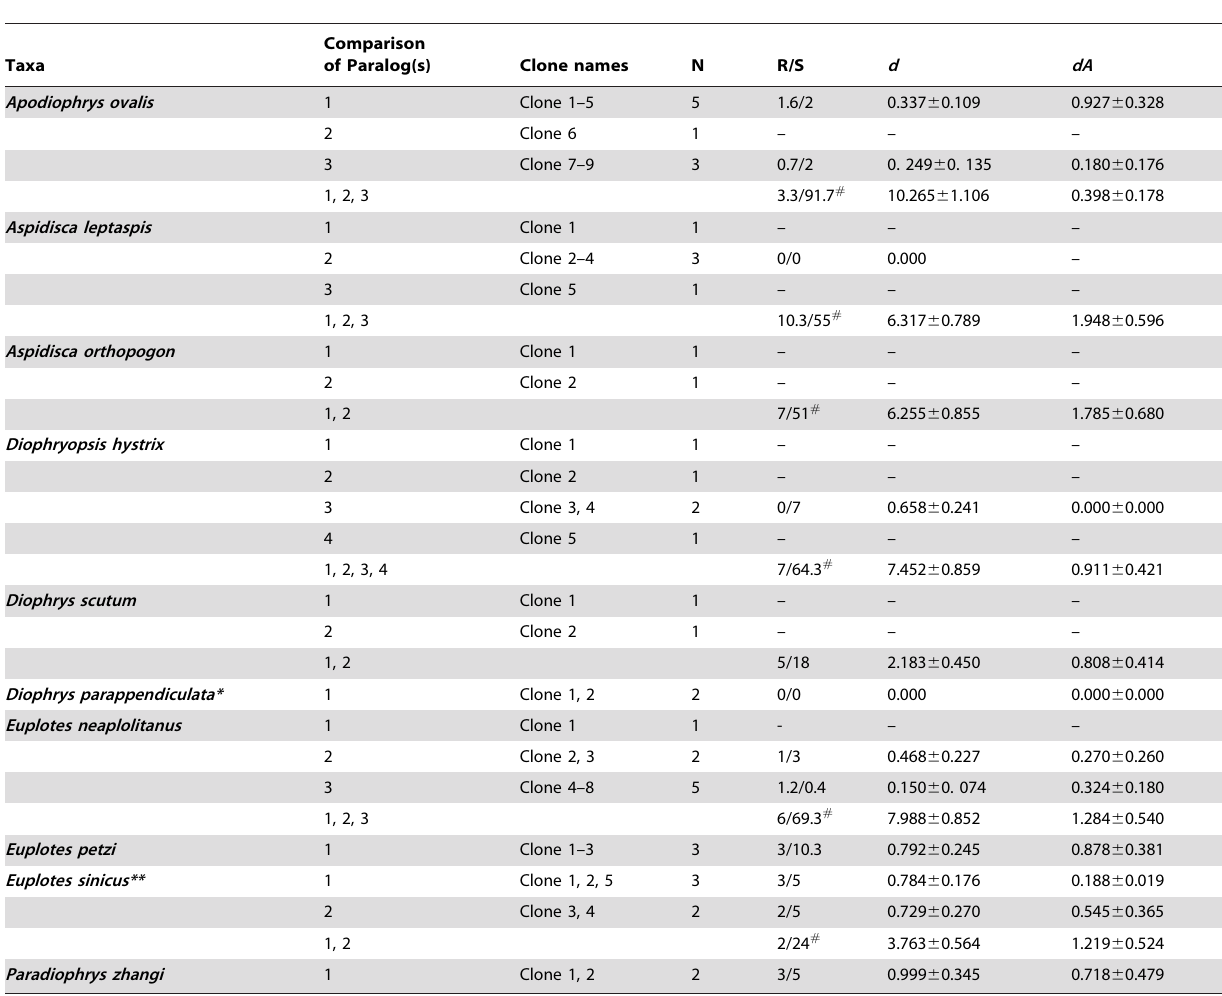
Table 2. Intraspecific Distances Between/Among a -Tubulin Clones and Between/Among Paralogs.